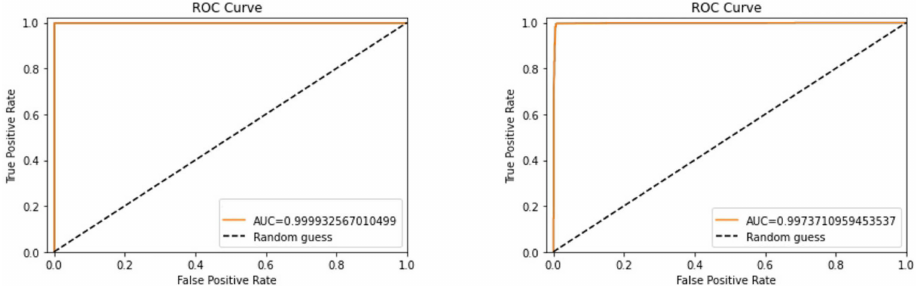
Figure 12. ROC curve related to CICDDoS2019